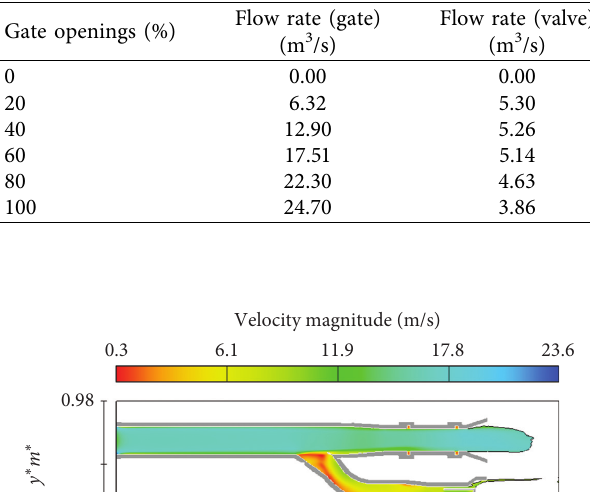
Table 4: Changes in bottom outlet’s output flow rate for different gate openings.